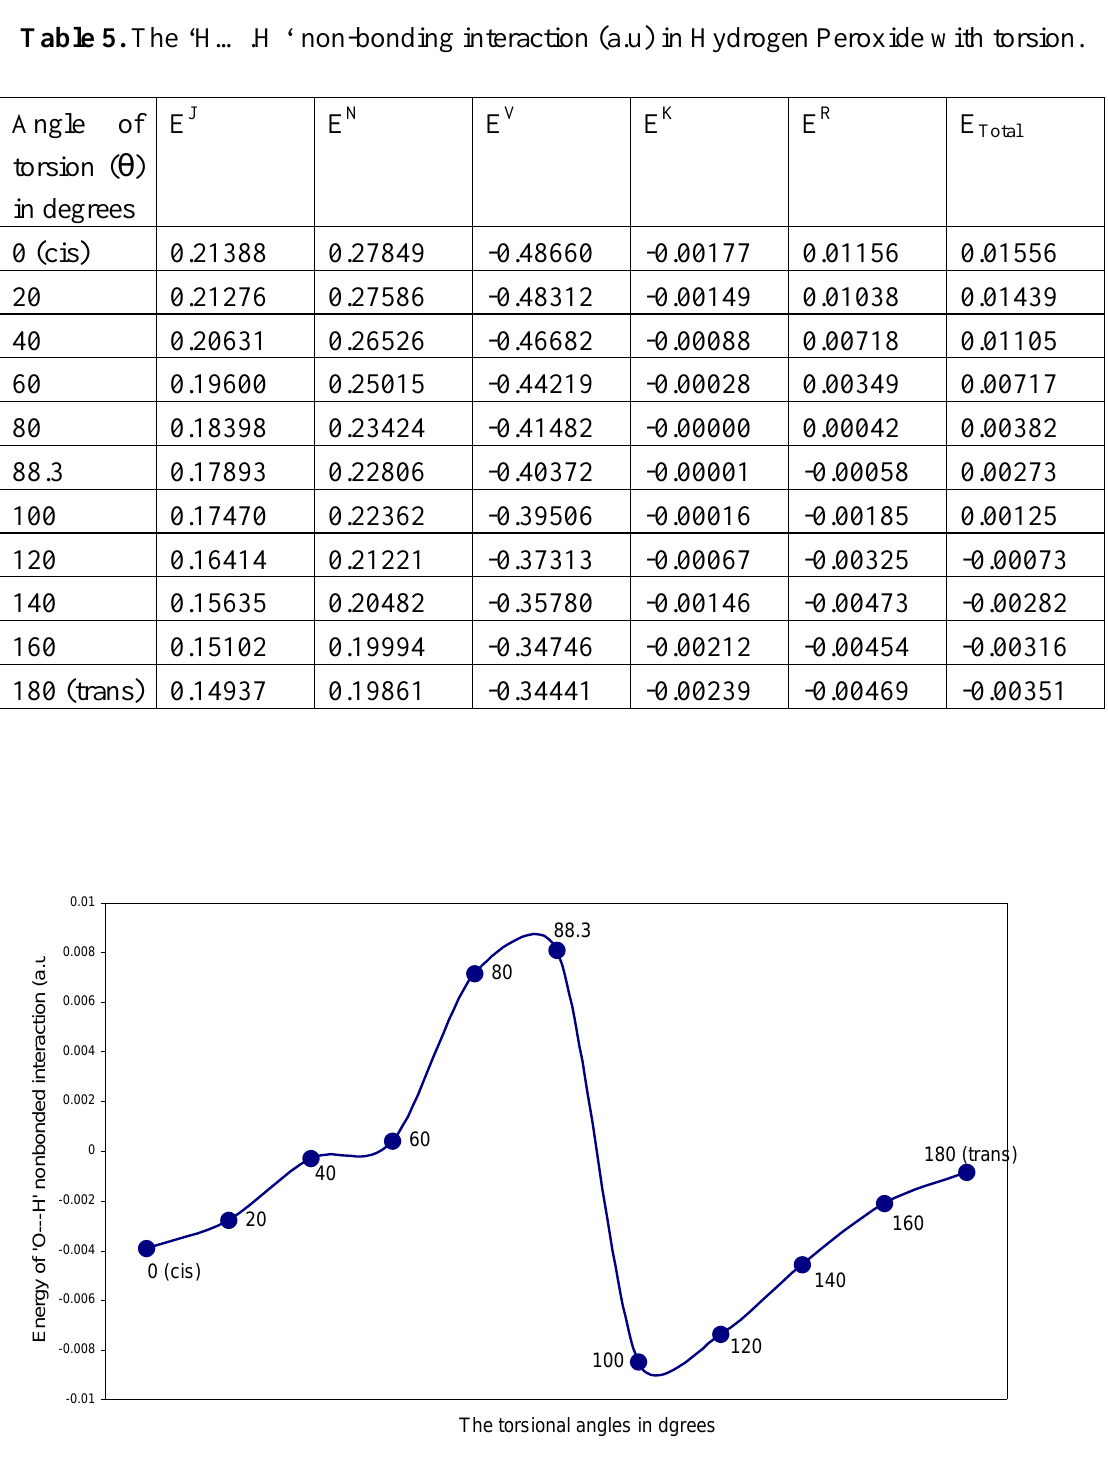
Figure 6. Plot 'O---H' nonbonding interaction as a function of torsional angles in Hydrogen